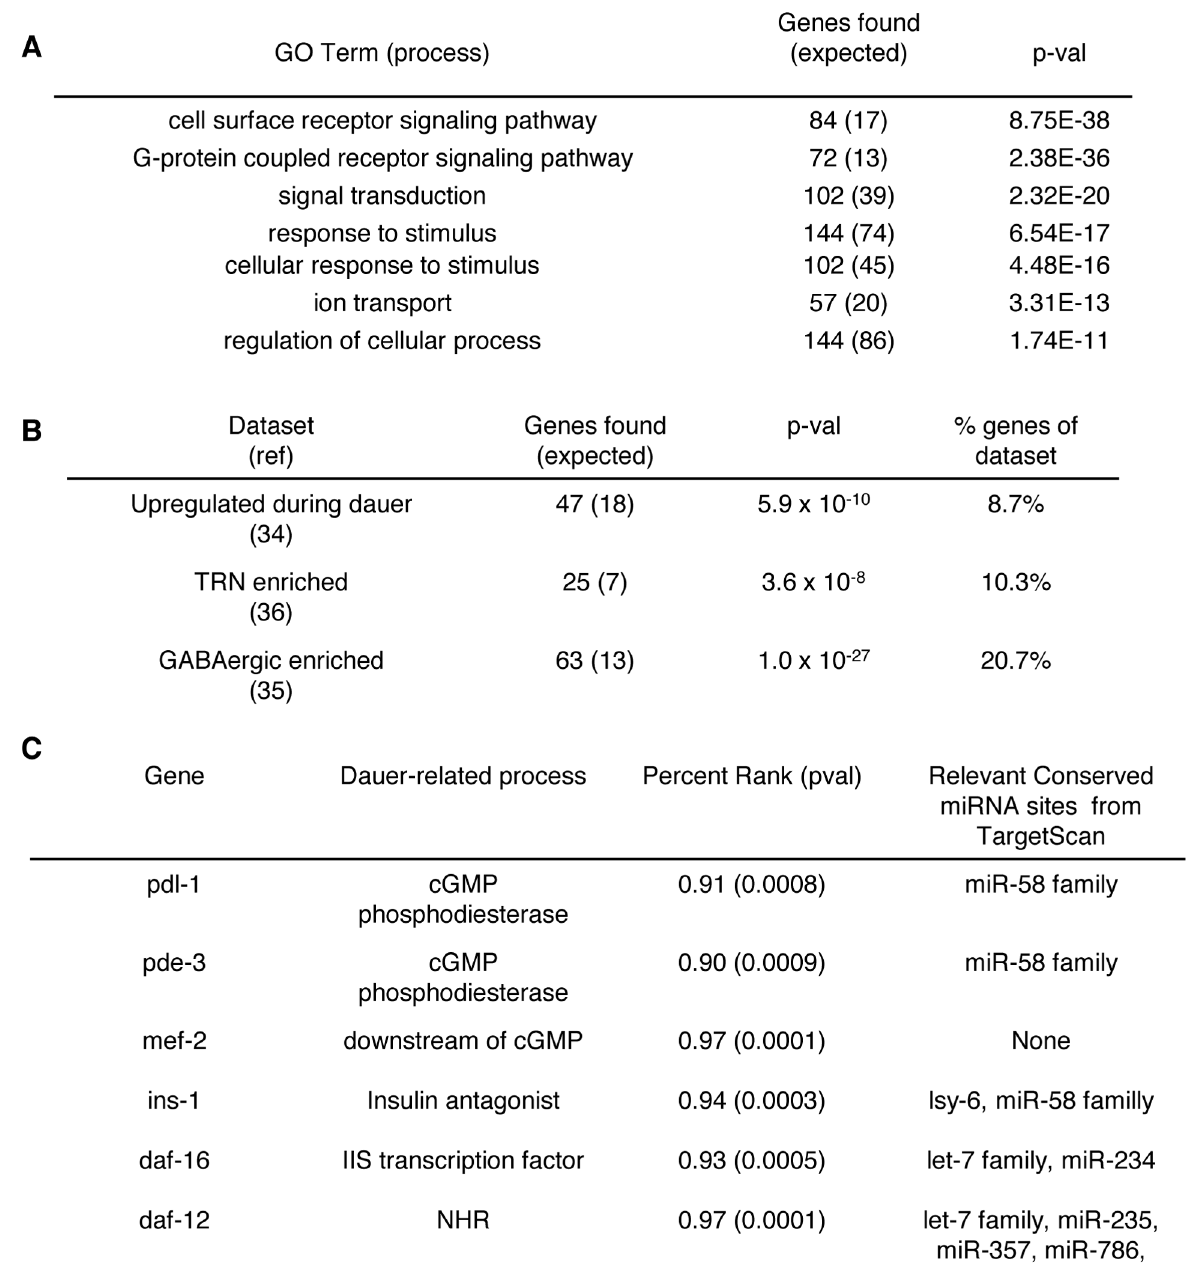
Figure 6. Neuronal miRNA targets have broad functions. A. Chart showing the top GO term enrichments of enriched genes versus testable genes using GOrilla. 9873 testable genes and 531 enriched genes were identified with GO terms. P-values and expected values were calculated using a hypergeometric distribution. B. Chart showing the enrichment of genes from various datasets within our neuronal AIN-2 IP. P-values and expected values were calculated using a hypergeometric distribution. C. Chart showing several genes that promote dauer formation and are associated with neuronal AIN-2. Relevant Conserved sites are sites that have some indication of belonging to a neuronal miRNA in this study or others.